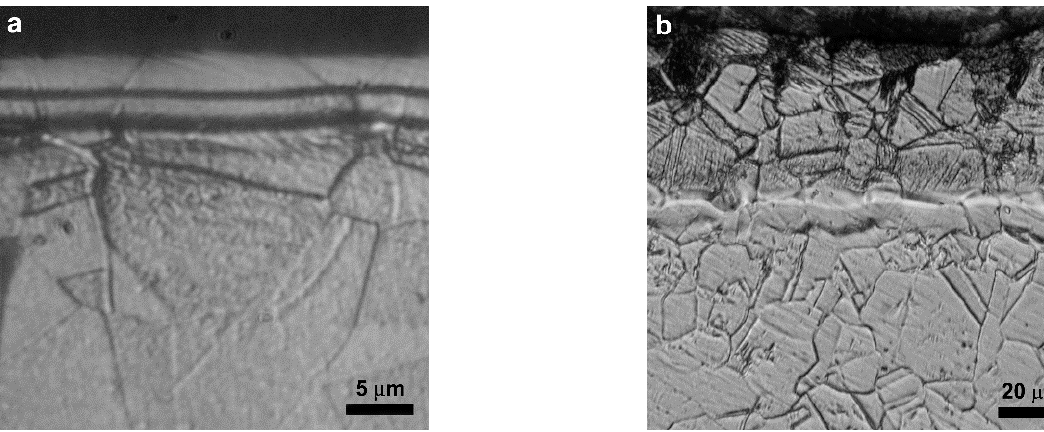
Figure 4. Cross-section ( a ) and tapered section (~10°) ( b ) of an AISI 316L sample plasma nitrided at 380 °C, 340 Pa, 3 h. For further experimental details, see [70]. (Etchant: acetic glyceregia (3 mL HCl, 2 mL HNO 3 , 2 mL acetic acid, 1 drop of glycerol; in ( b ) the marker refers to the length in the tapered section)).